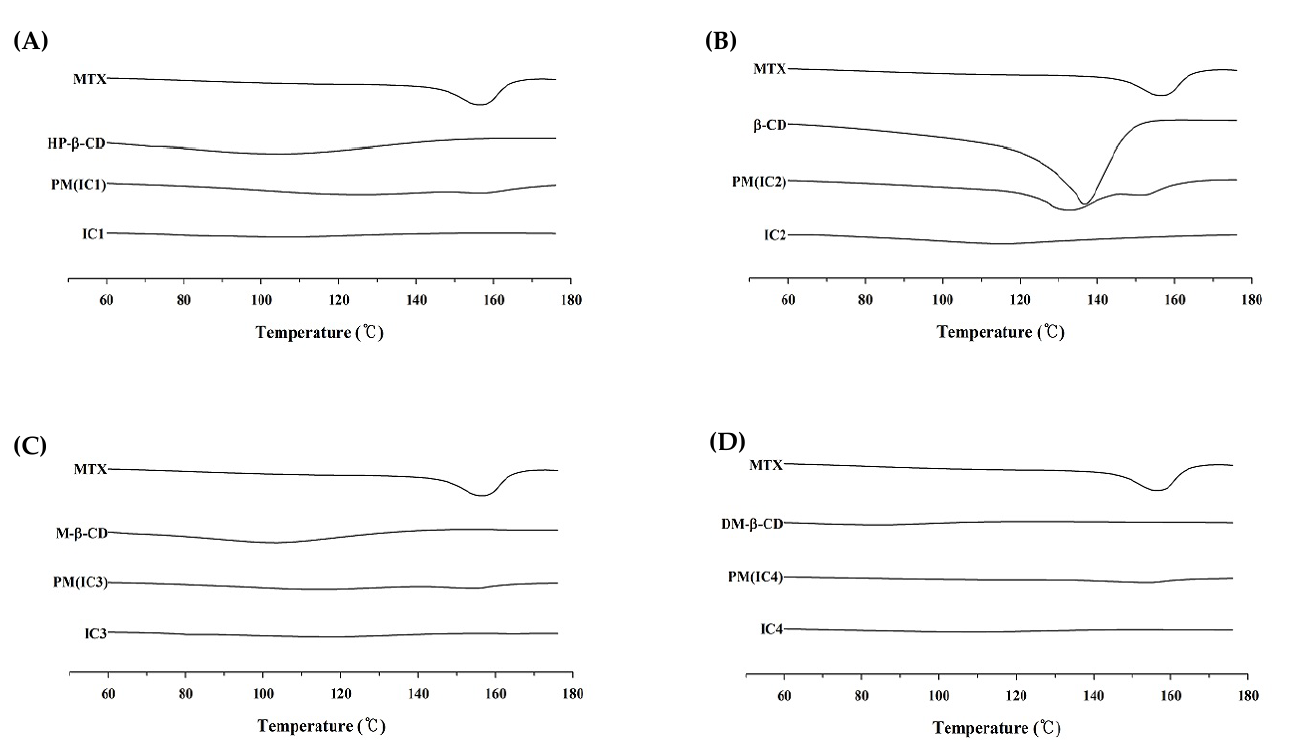
Figure 4. DSC thermograms of the MTX powder, cyclodextrins, physical mixtures, and MTX-CD inclusion complex formulations: ( A ) MTX/HP- β -CD inclusion complex (IC1); ( B ) MTX/ β -CD inclusion complex (IC2); ( C ) MTX/M- β -CD inclusion complex (IC3); and ( D ) MTX/DM- β -CD inclusion complex (IC4).